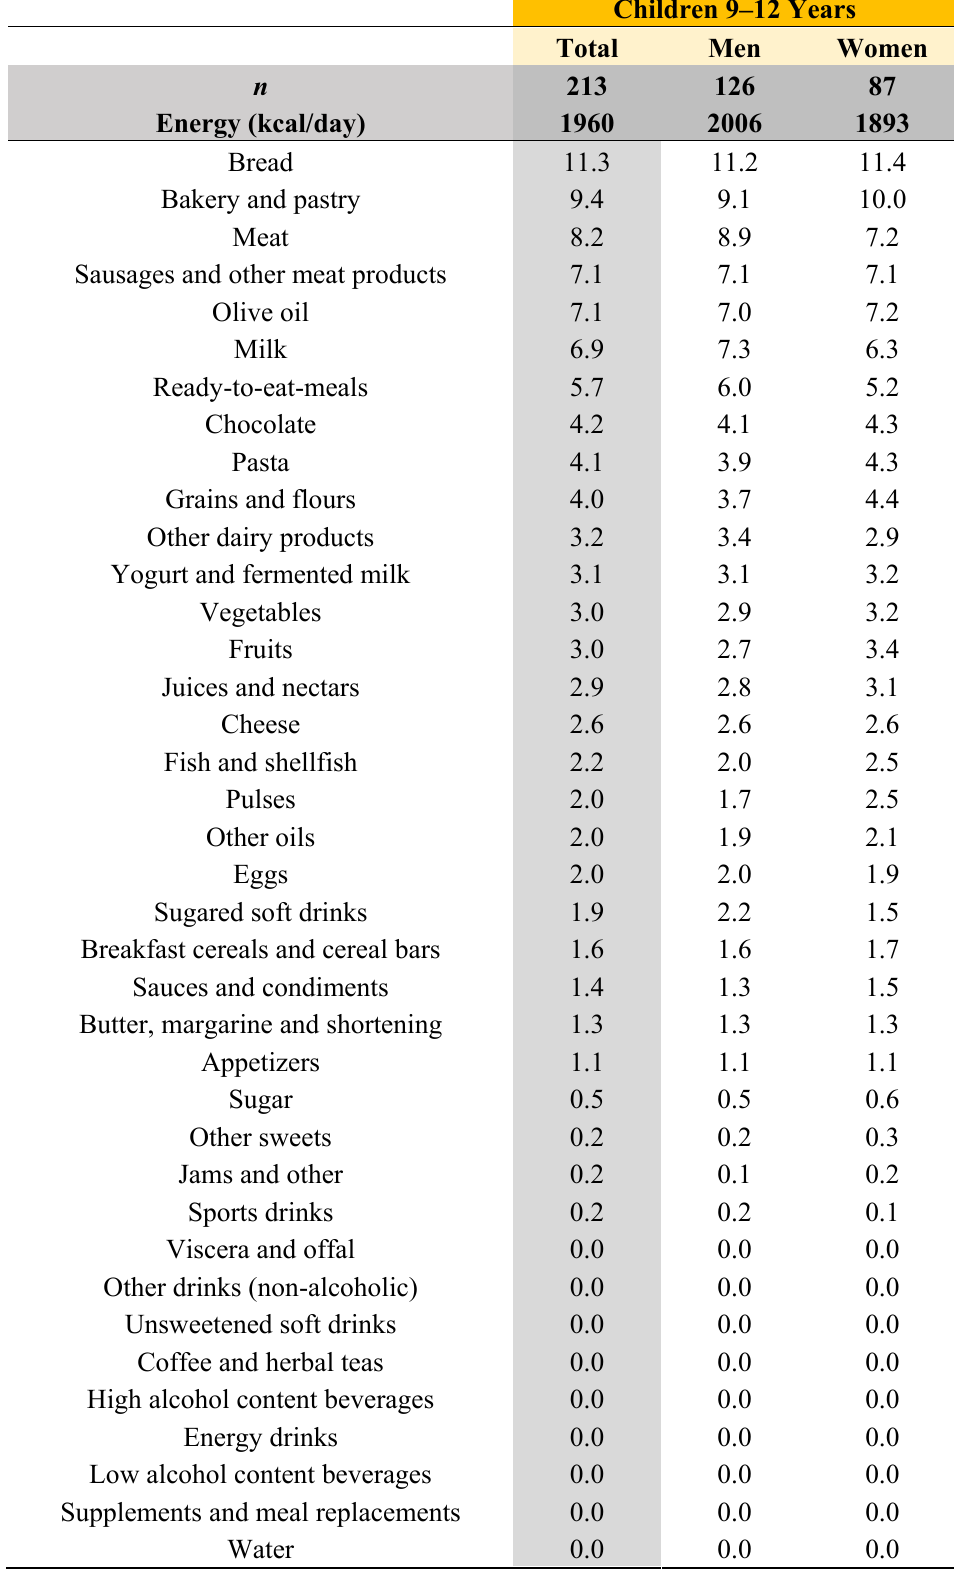
Table 6. Dietary sources of energy (%) from food subgroups in children from the ANIBES survey of the Spanish